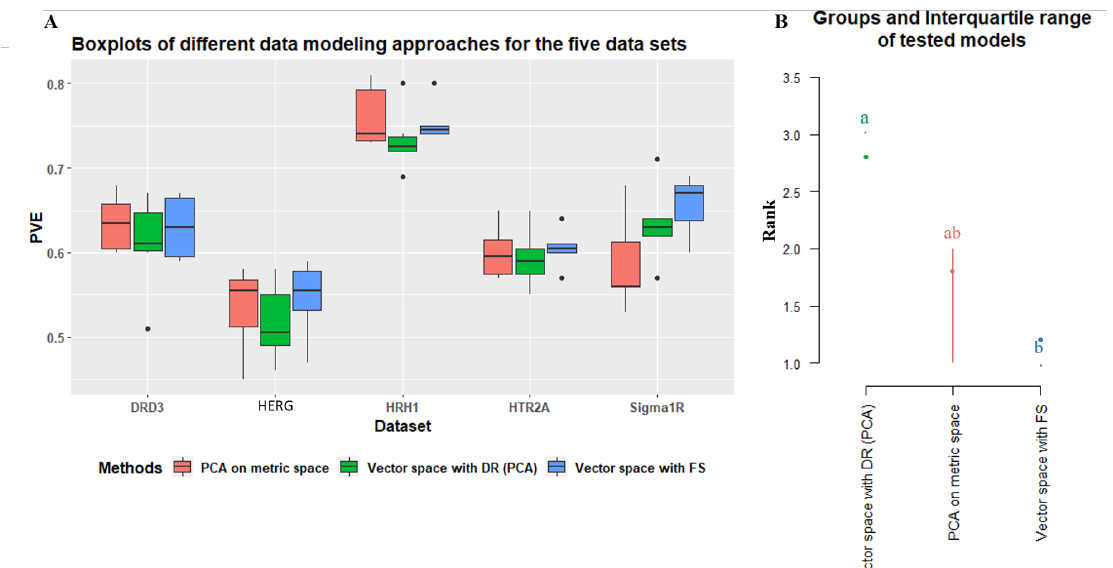
Figure 5. ( A ) Boxplots of the three modeling approaches grouped by the different data sets; ( B )